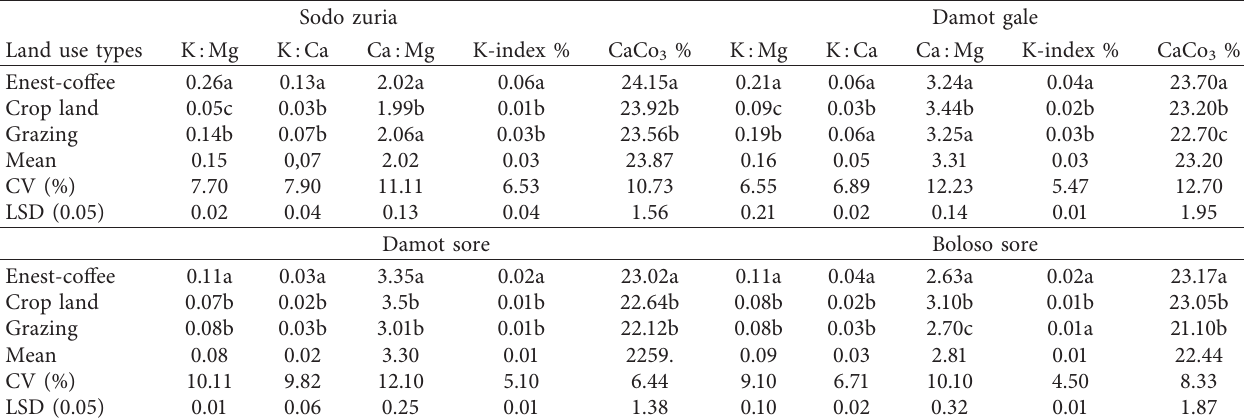
Table 5: Mean values ( n � 108) of basic cation saturation ratio, K saturation percentage, and calcium carbonate in different locations and land use types.